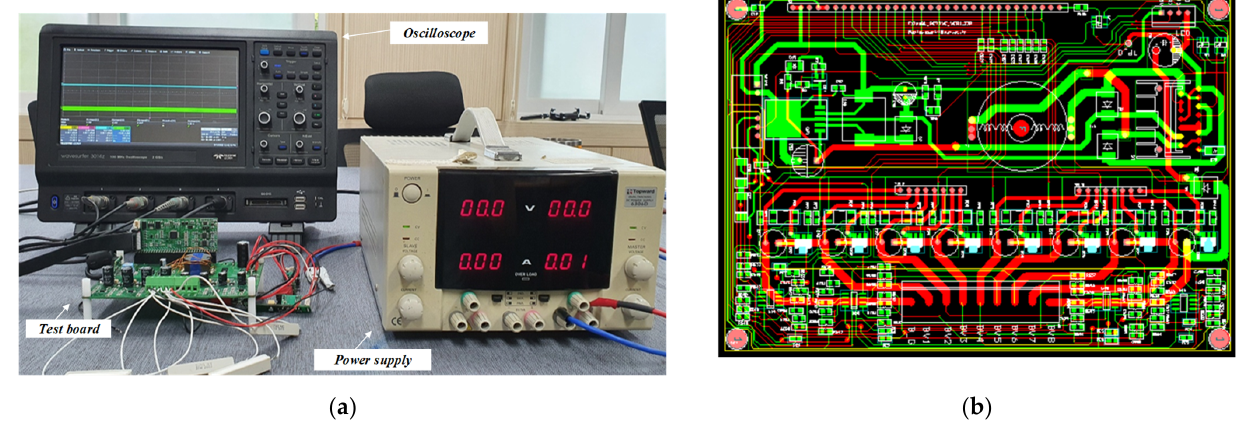
Figure 15. Test setup for experiment. ( a ) Overall setup, ( b ) Gerber file. Table 1. Circuit Parameters for Experiment.